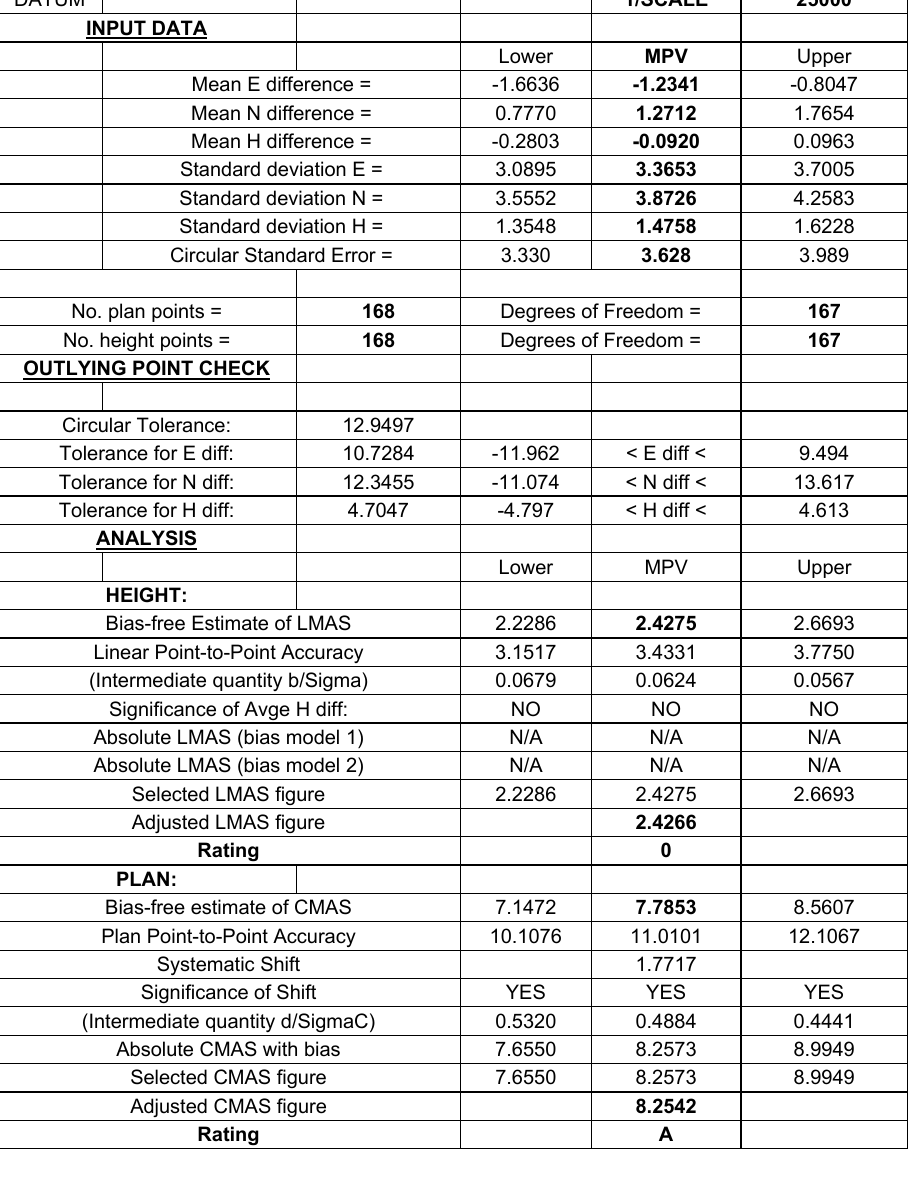
Таблица 4 – Стандартизованный отчет о позиционной точности на тестируемой местности Табела 4 – Стандардизовани извештај оцене положајне тачности тест -